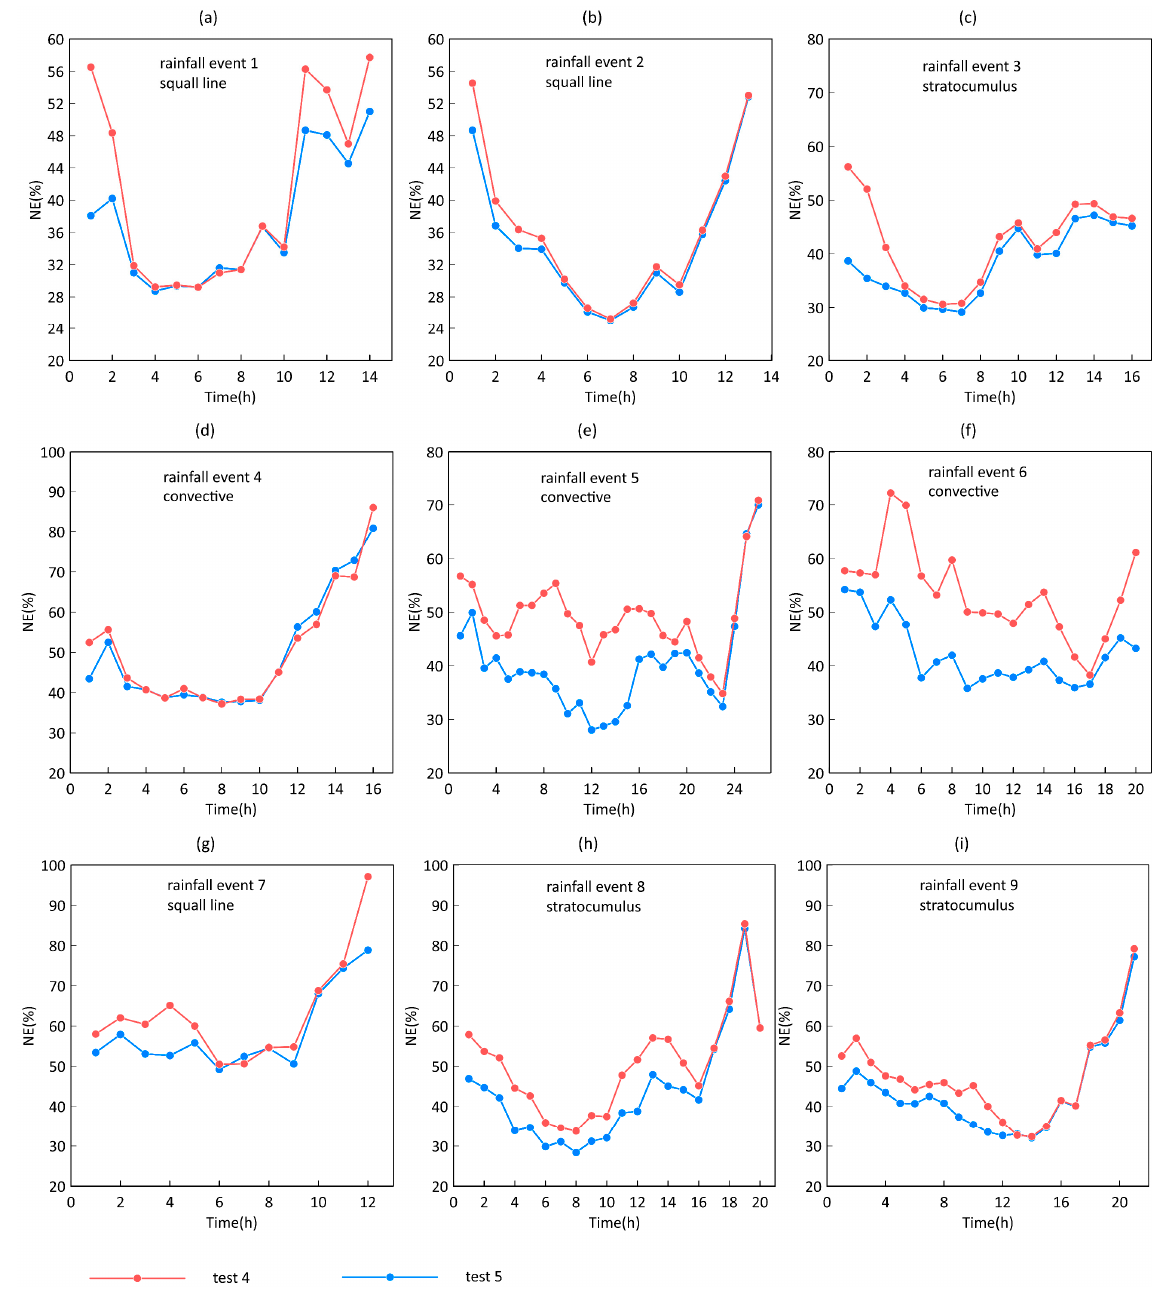
Figure 6. ( a – i ) Time series of NE values for the rainfall event 1–9. The QPE performance at CRQI > 0.0 was evaluated. The red and blue lines represent NE values in tests 4 and 5,